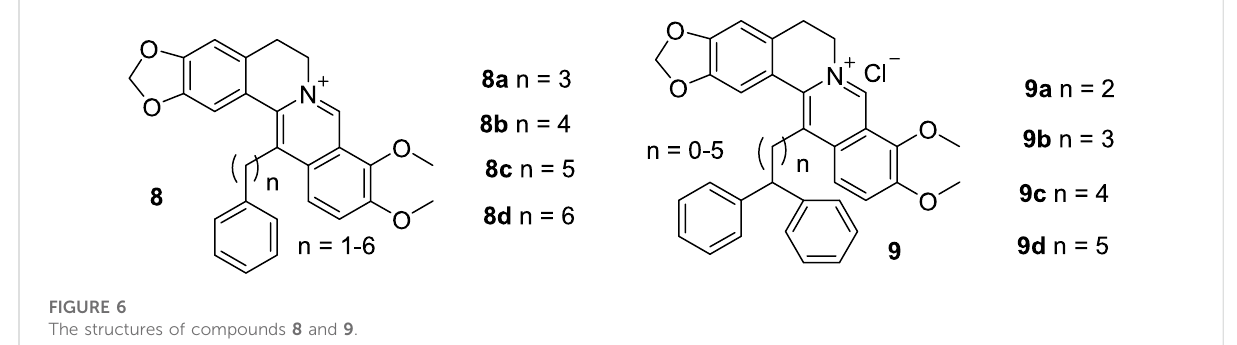
FIGURE 6 The structures of compounds 8 and 9 .